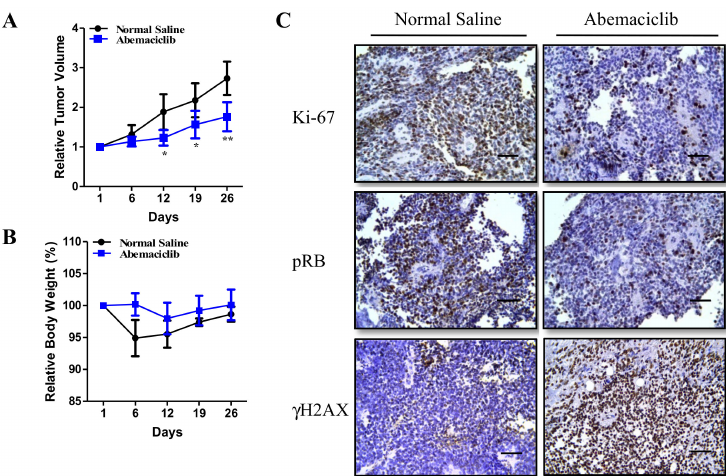
Figure 6. Abemaciclib treatment inhibits patient-derived ependymoma xenografts growth in vivo. ( A , B ) The third-generation xenografts were injected subcutaneously into the flank regions of nude mice, and abemaciclib was administered orally (50 mg / kg / day) five times per week. Tumor volume ( A ) and body weight ( B ) were recorded every 6 or 7 days. The figure shows the relative tumor volume and body weight compared with those at the first abemaciclib feeding. * p < 0.05, ** p < 0.01. ( C ) IHC staining for detection of Ki-67 and γ H2AX expression and RB phosphorylation after abemaciclib treatment. Scale bar: 50 µ